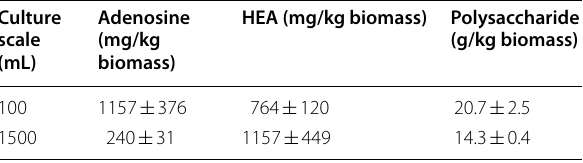
The data is presented as the mean